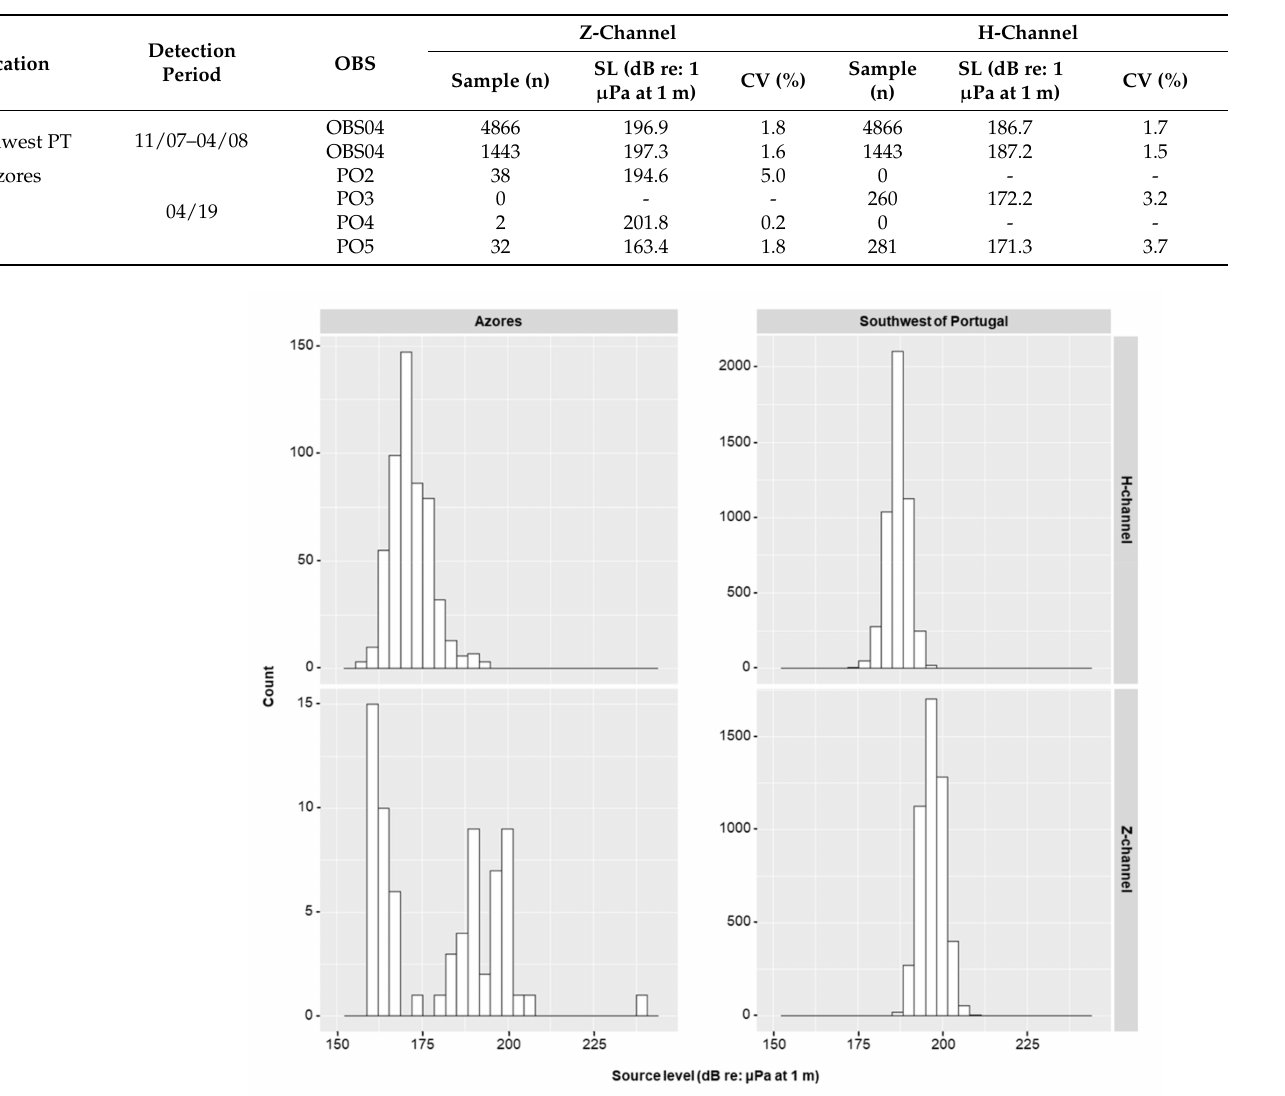
Table 3. Estimated fin whale mean source levels (SL) and the corresponding coefficient of variation as a function of the deployment location, detection period, and sample size. The sample size of the Z-channel of the Azores dataset corresponds to notes that were accepted after the incidence angle filtering.